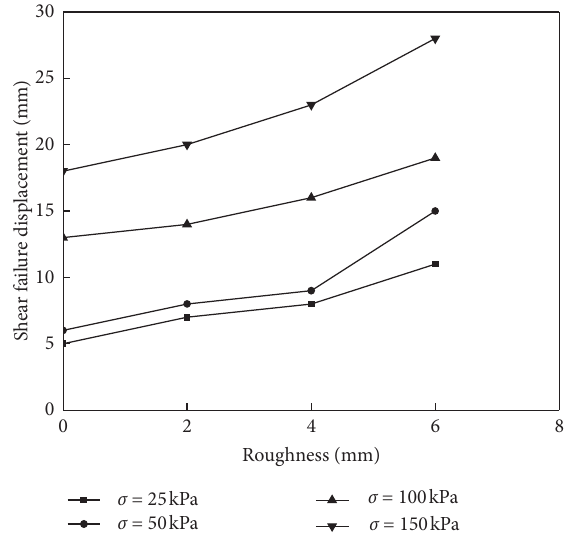
Figure 13: Relationship between interface shear failure displace- ment and